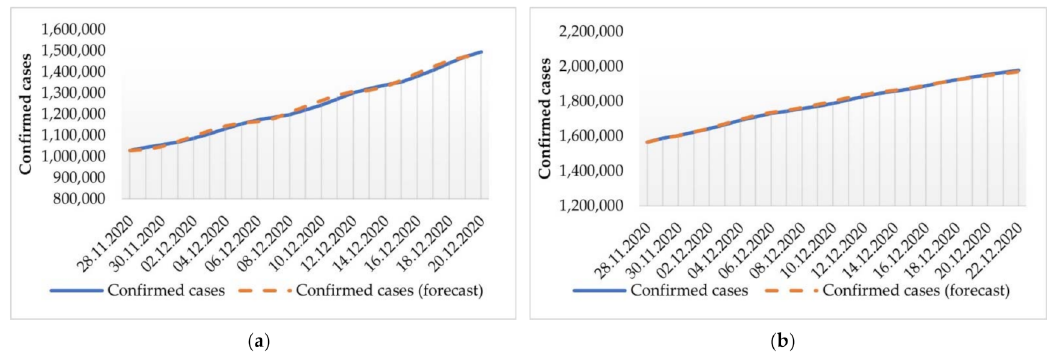
Figure 12. Dynamics of C ( t ) , the actual and modeled trajectories in December 2020, in ( a ) Germany and ( b ) Italy.